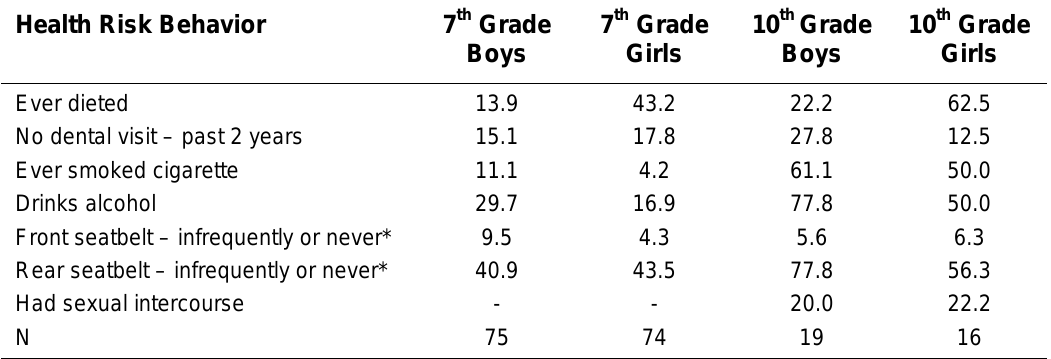
Selected Health Risk Behaviors (Percentages)